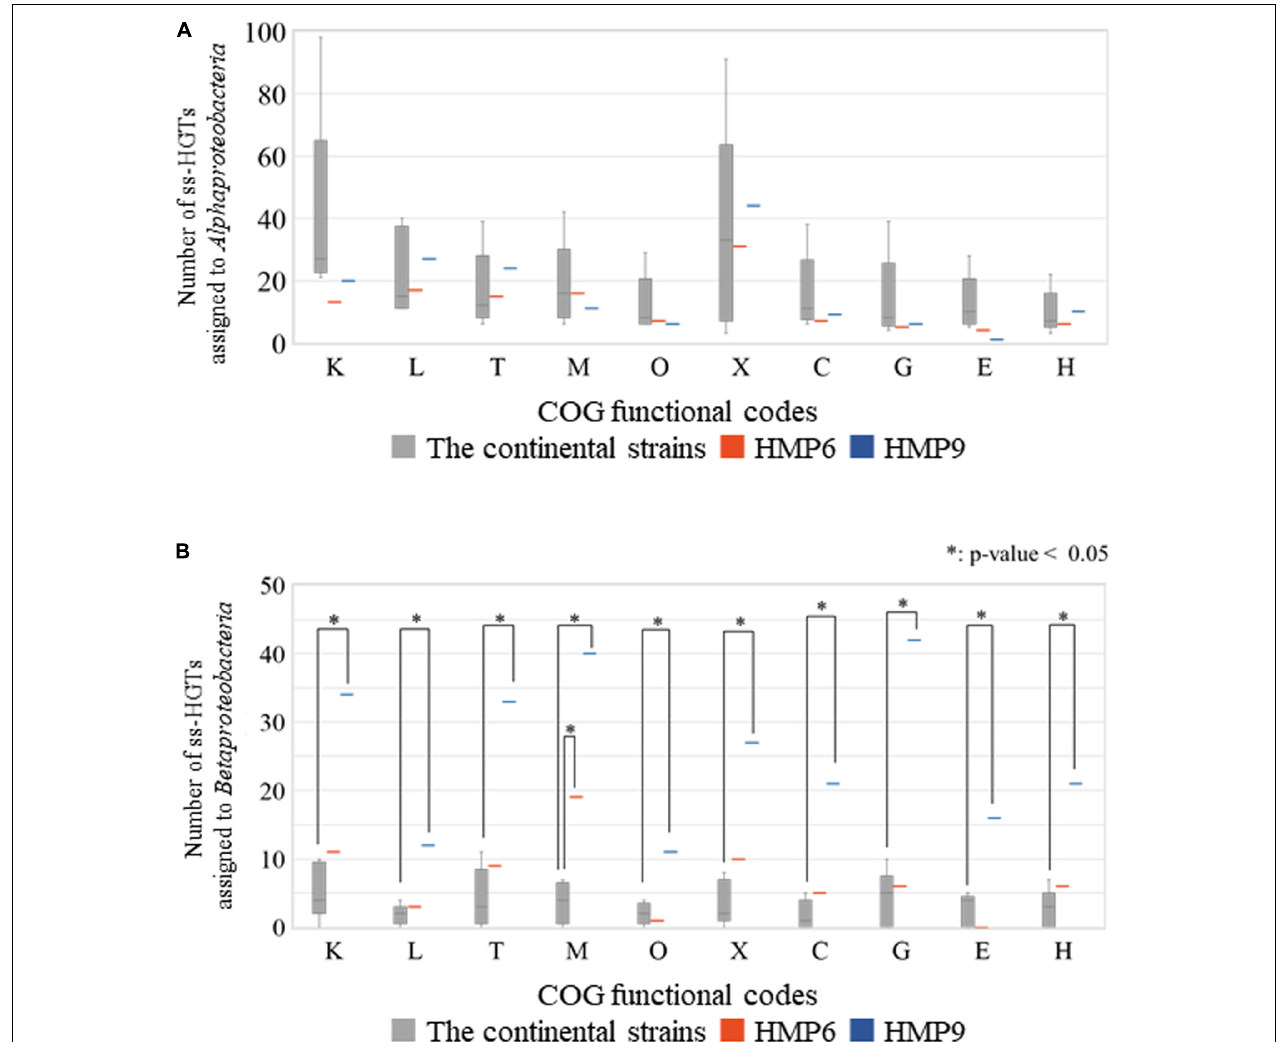
FIGURE 8 | Number of strain-specific HGT candidates (ss-HGTs) assigned to (A) Alphaproteobacteria and (B) Betaproteobacteria according to their COG functional categories showing significant differences between the continental and the Antarctic HMP6 and HMP9 strains. Gray ( (cid:4) ): continental strains; orange bar ( (cid:4) ): HMP6 strain; blue bar ( (cid:4) ): HMP9 strain. Asterisks: significant difference between continental and Antarctic